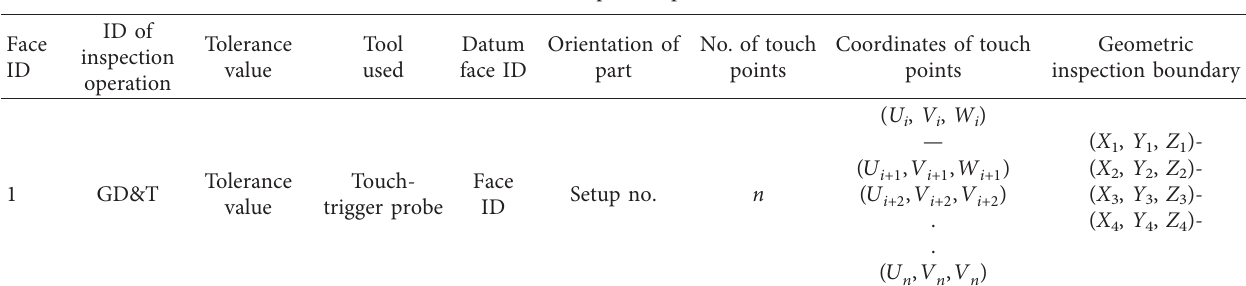
Table 5: Inspection plan